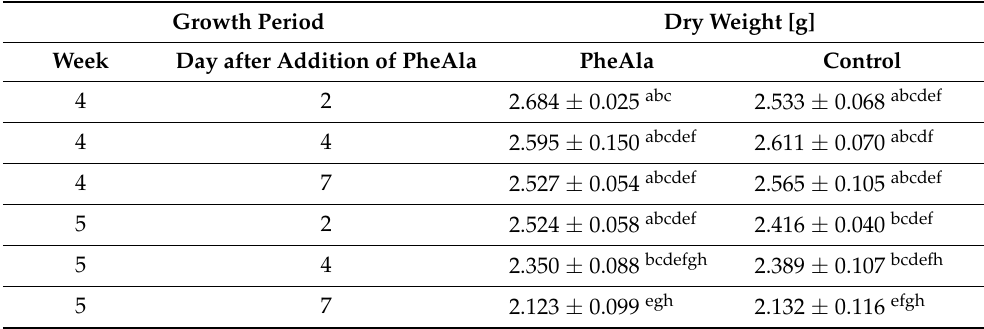
Table 1. Dry weight [g] obtained from R. graveolens agitated cultures. Mean of three replications. Different letters indicate significant differences ( p < 0.05). PheAla—phenylalanine. Growth